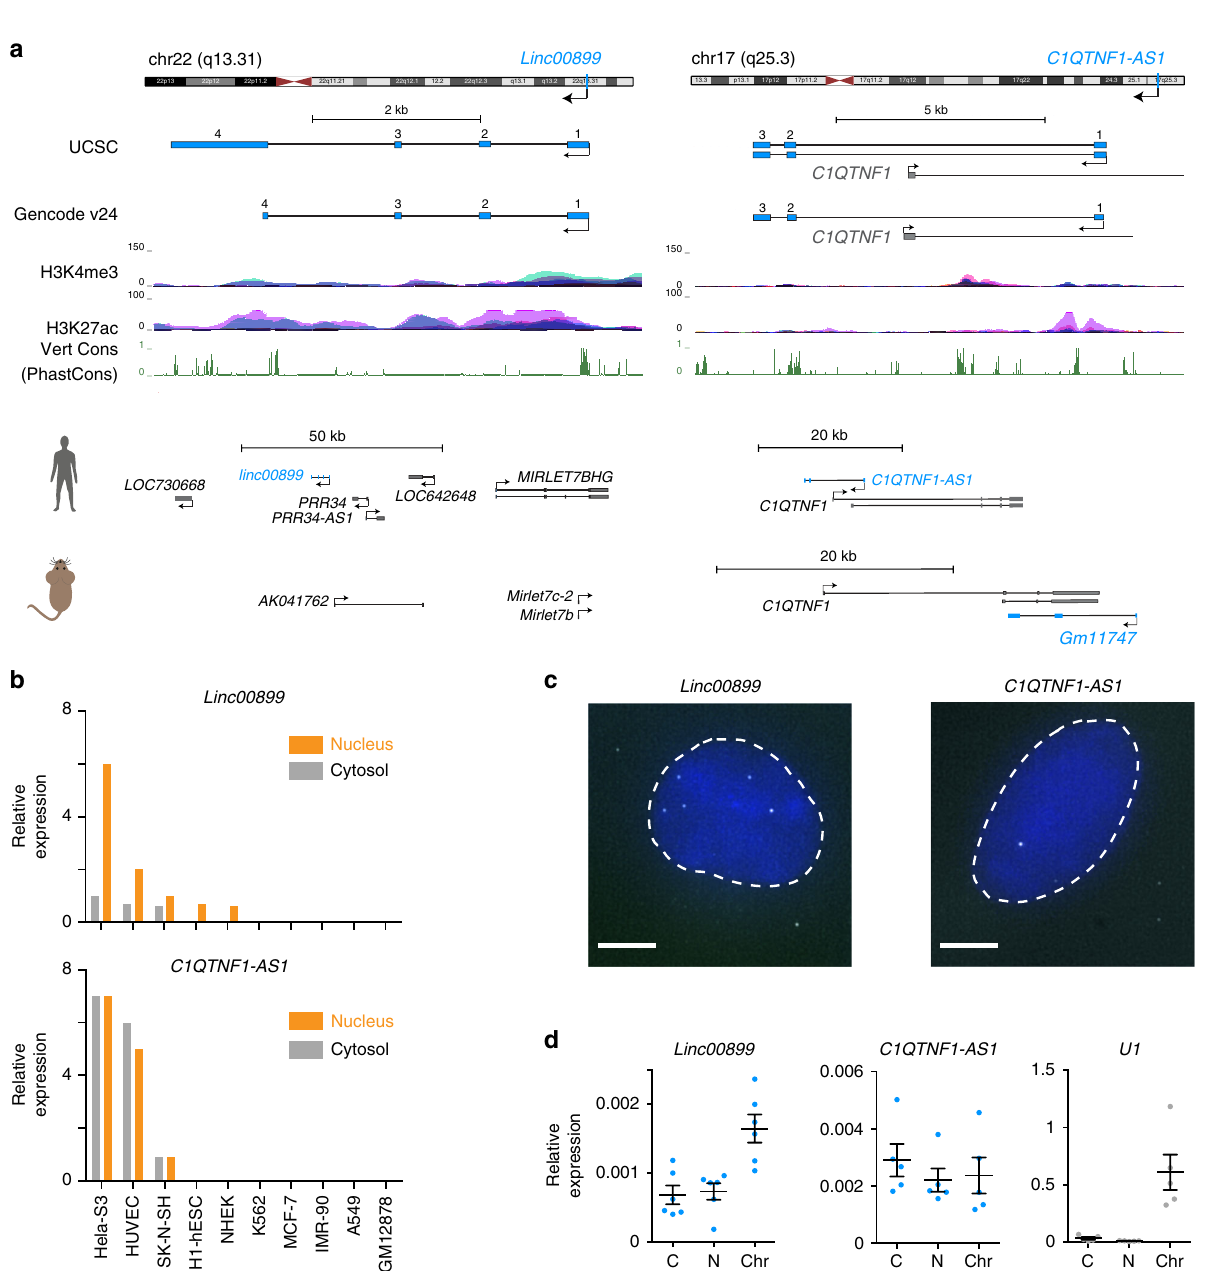
RNAi- and LNA-mediated depletion of C1QTNF1-AS1 (Supple- mentary Fig. 8). These results suggest that the C1QTNF1-AS1 transcript, and not transcription at the C1QTNF1-AS1 locus, is required for the regulation of mitotic progression. Similar experi- ments for linc00899 were hindered by the presence of over four copies of linc00899 in the HeLa genome (https://cansar.icr.ac.uk/ cansar/cell-lines/HELA/copy_number_variation/) preventing the